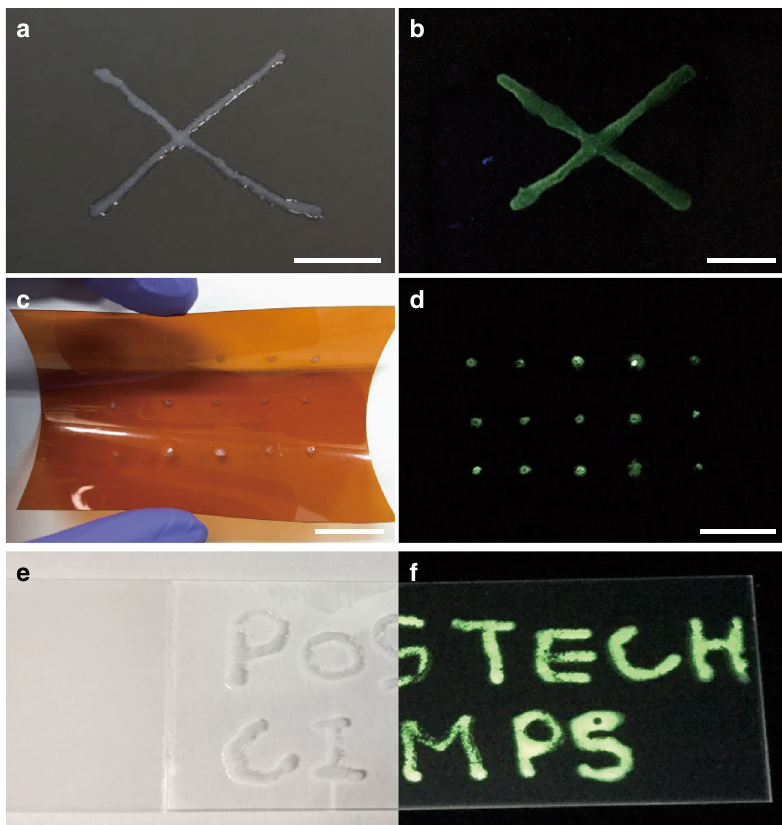
Fig. 4 Mesoporous MOF patterns. a Photo and b luminescence images of “ X ” -shaped UiO-66-d40 pattern on an Si substrate (scale bar is 0.5 cm). c Photo and d luminescence images of dot-shaped UiO-66-d40 pattern on fl exible polyimide fi lm (scale bar is 2 cm). e Photo and f luminescence images of “ POSTECH ” patterned UiO-66-d40 on a glass